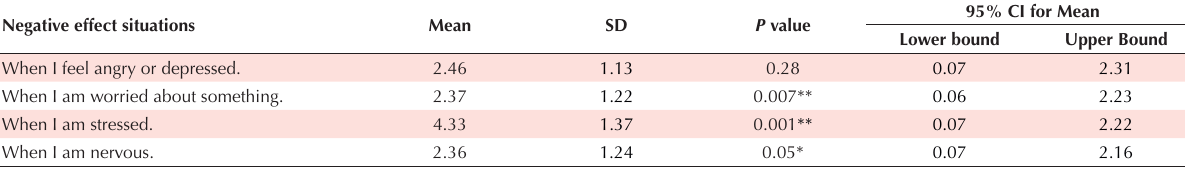
95% CI for Mean Lower bound Upper Bound